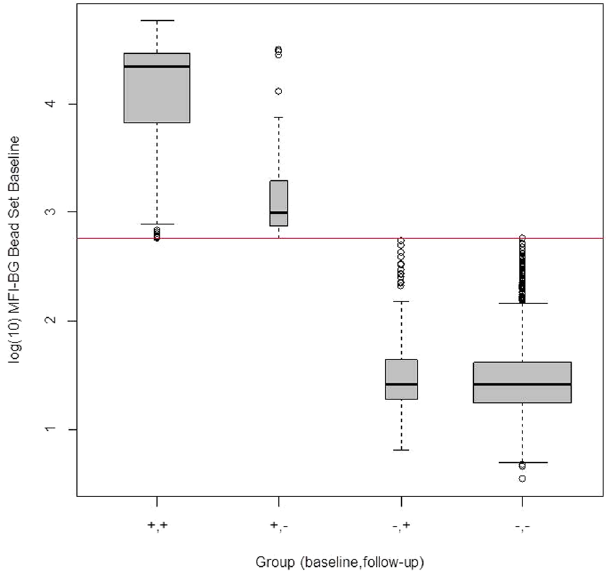
Figure 2. Log 10 MFI-BG at baseline for the longitudinal cohort within the four groups according to antibody status at baseline and follow